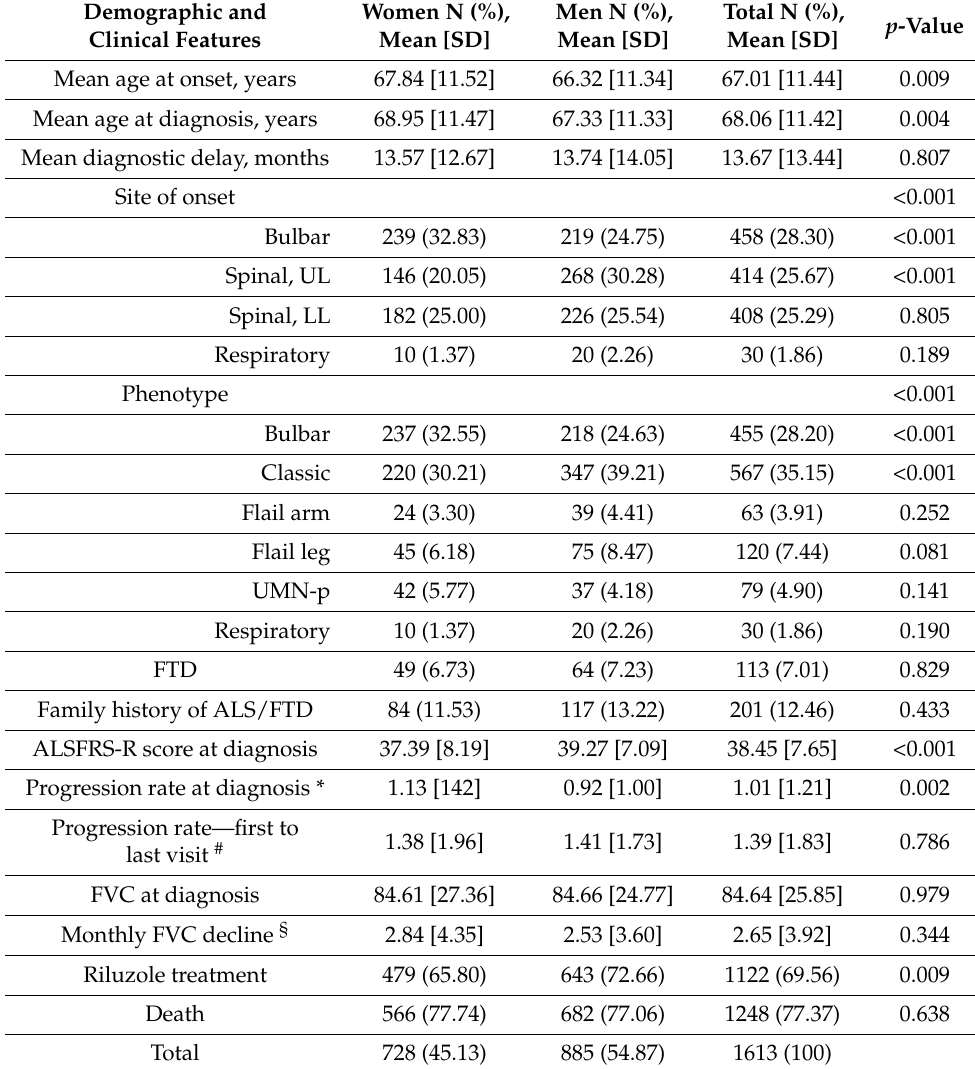
Table 1. Demographic and clinical features of the ALS patients, stratified by sex. Demographic